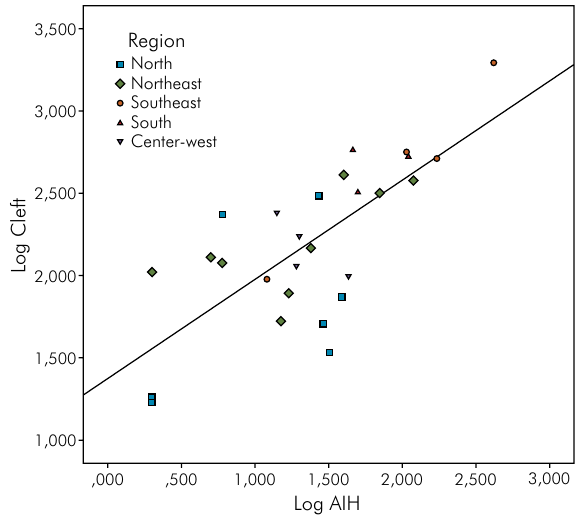
Figure 5. Relationship between the number of live births with orofacial clefts and the number of Authorization Forms for Hospital Admittance (AIHs) related to surgical procedures for orofacial clefts in Brazil from 2009 and 2013. Data displayed in logarithmic